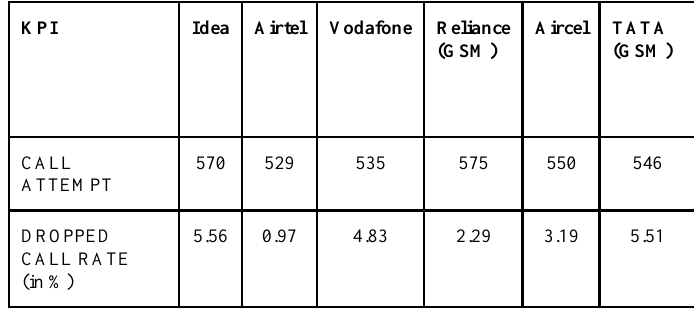
Table 3. Results of drive tests conducted by TRAI at Mumbai in June,